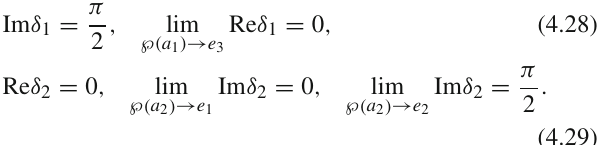
Fig. 5 The entangling curve and the corresponding boundary regions in global and Poincaré